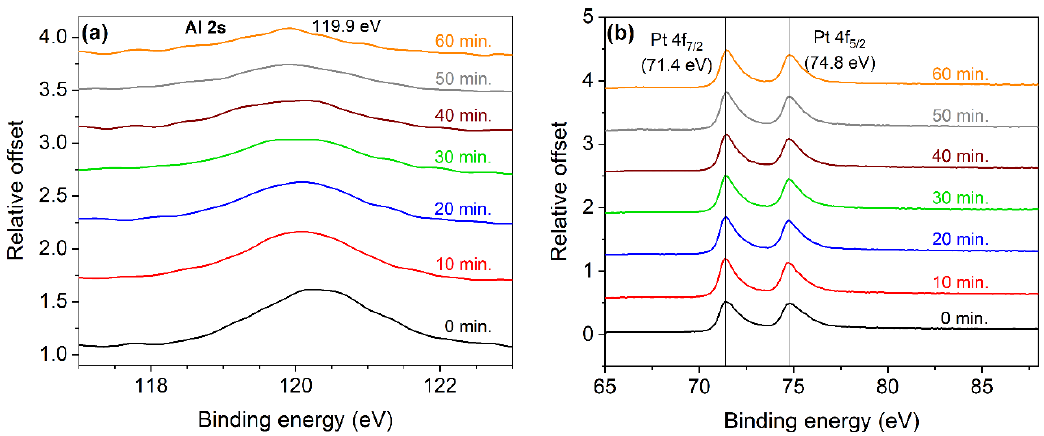
Figure 7. The measured XPS spectra attributed to Al ( a ) and Pt ( b ) after various etching times. Coatings 2020 , 10 , x FOR PEER REVIEW